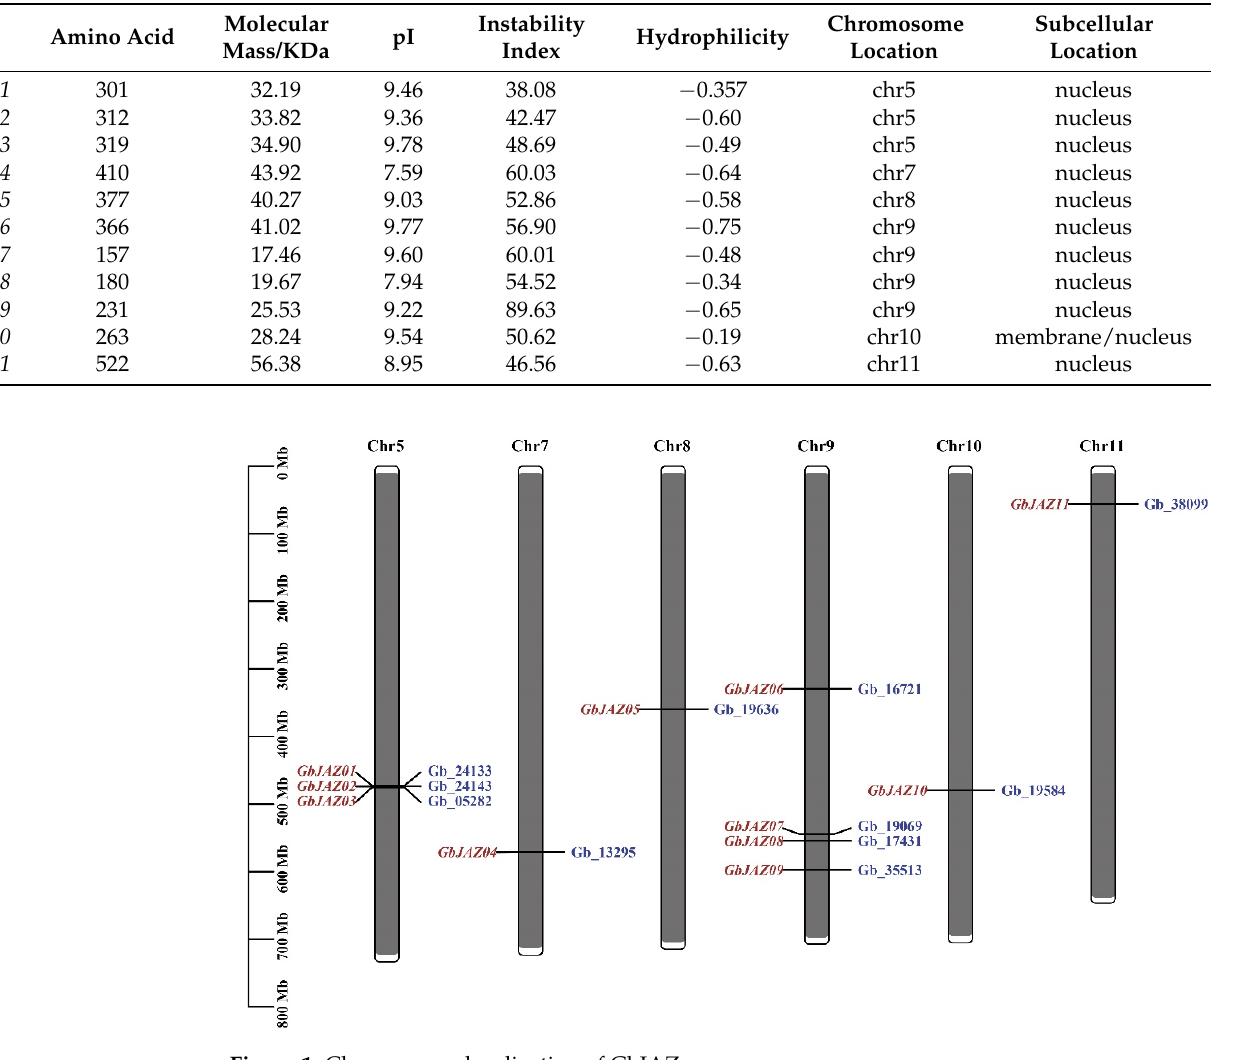
Figure 1. Chromosome localization of